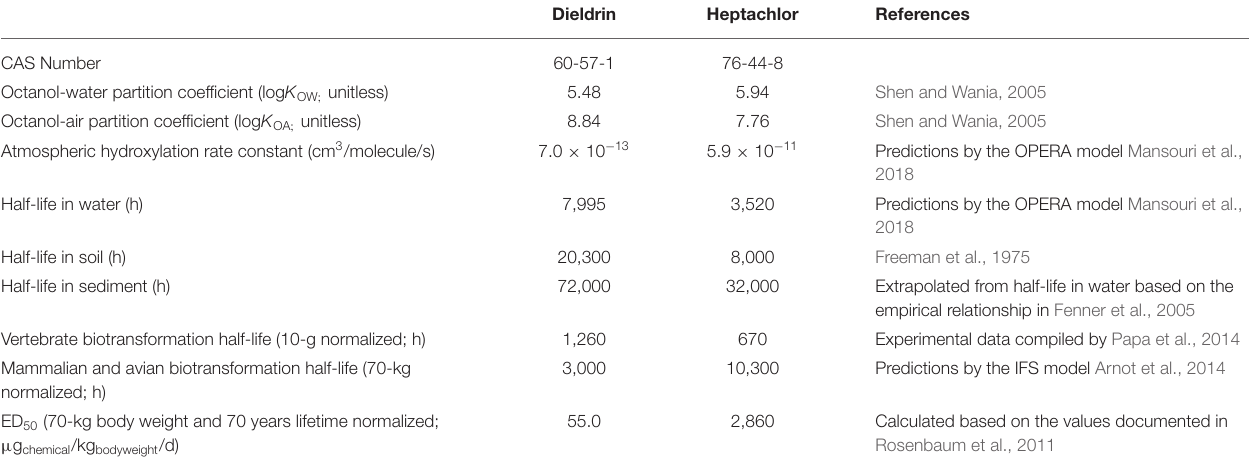
TABLE 1 | Physicochemical properties and toxicity values of dieldrin and heptachlor.